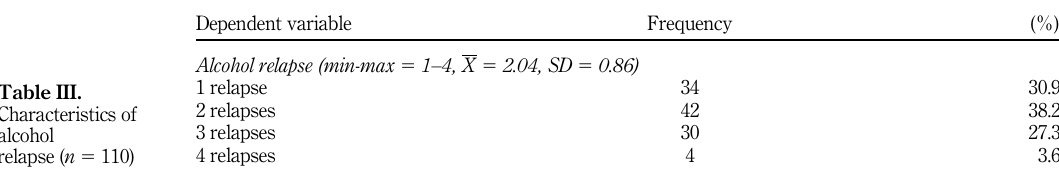
Table III. Characteristics of